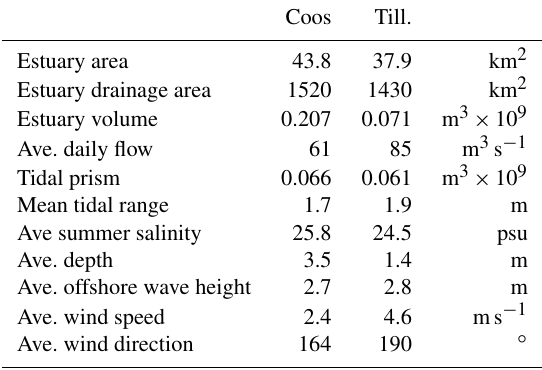
Table 1. Coos and Tillamook estuarine characteristics (after Engle et al., 2007). Wind characteristics are at tide gauge locations. Wave characteristics are offshore at buoys 46002 and 46005. Streamflow values are from this study’s hydrological